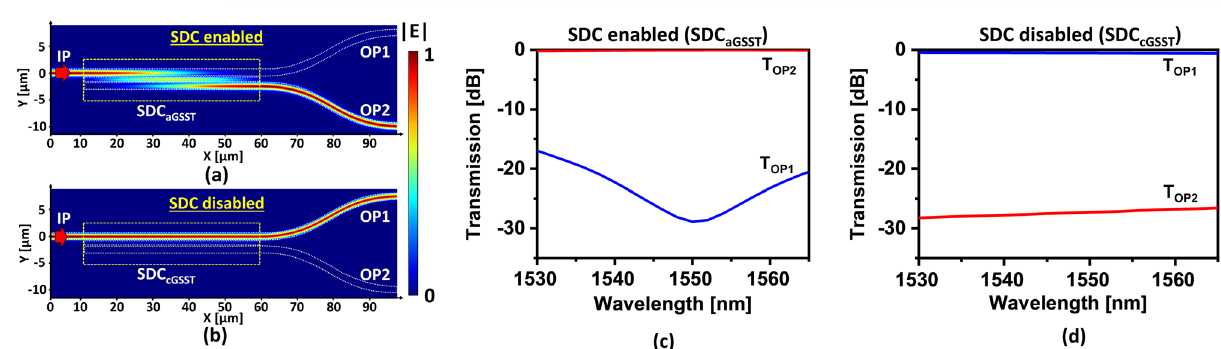
Figure 4. ( a ) Coupling of light from the input port IP to the output port OP2 when the SDC is operated under aGSST state. ( b ) Under cGSST state, no coupling occurs, and the output exits OP1. The spectral transmission of the two ports is observed for the SDC-enabled and disabled cases of ( c ) aGSST and ( d ) cGSST,